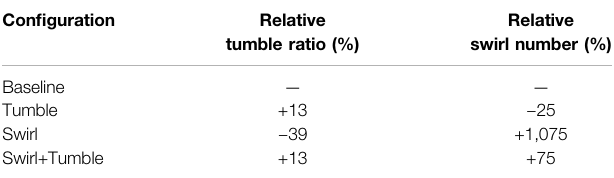
TABLE 2 | Relative change in tumble ratio and swirl number with various intake port insert con fi gurations, relative to the baseline con fi guration.